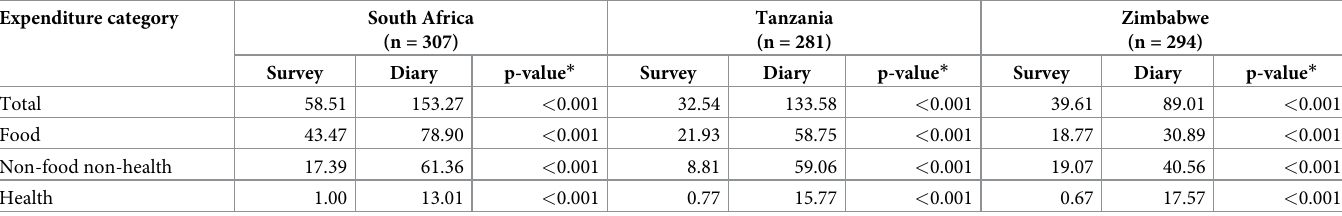
Table 2. Mean monthly household per capita expenditure via PURE survey vs pictorial diary, 2014 USD.